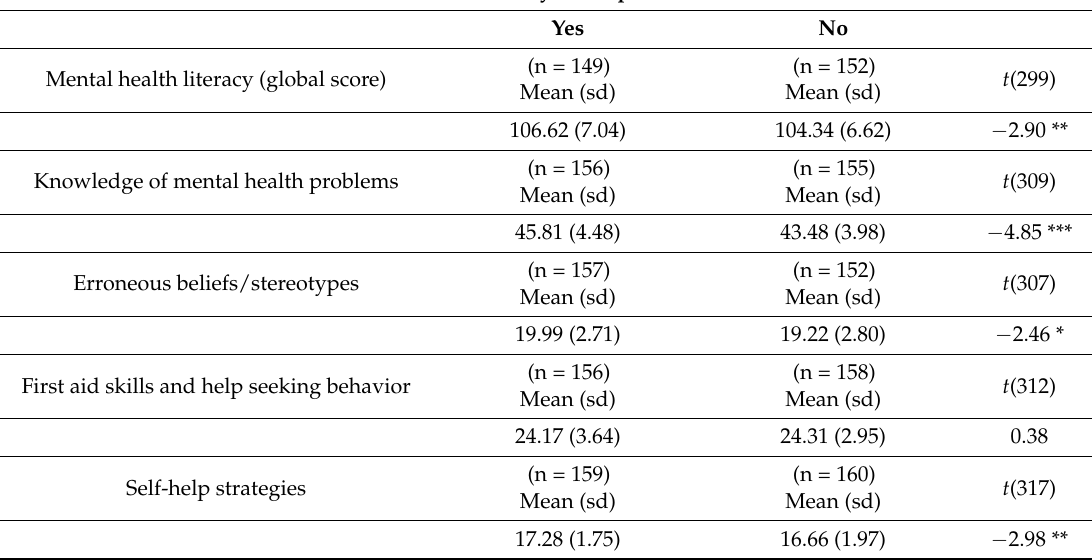
Table 5. Differences in mental health literacy (MHLq global score and dimensions) based on proximity to people with mental health